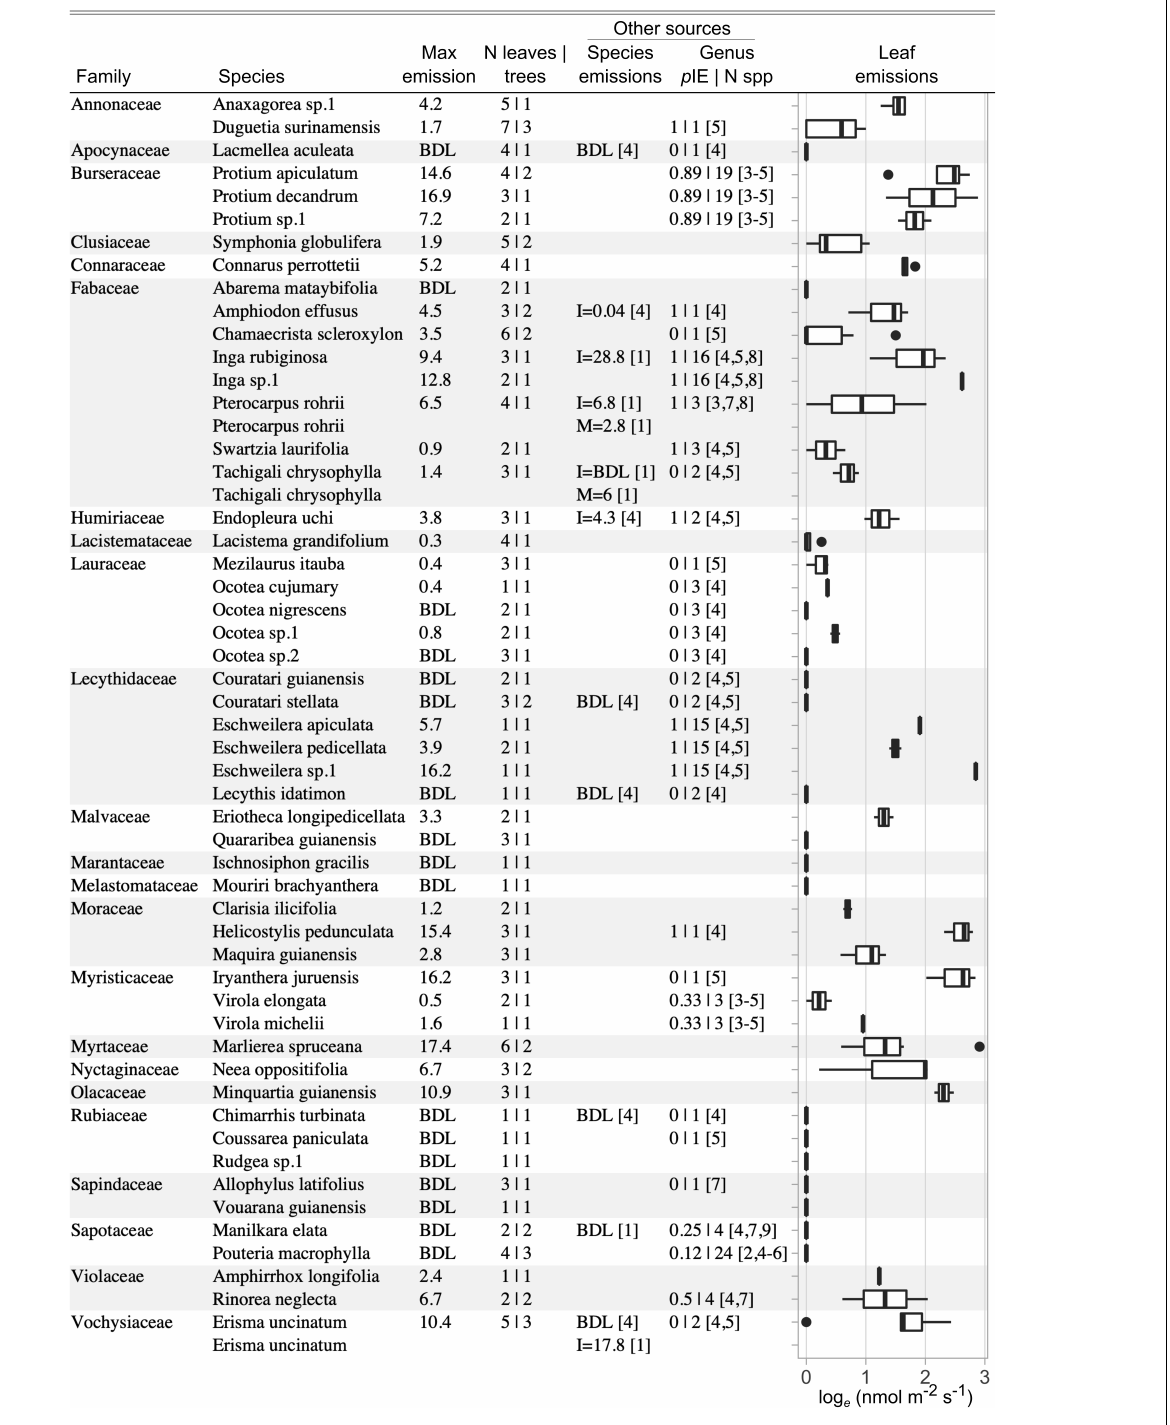
FIGURE 13 | Volatile isoprenoid emission rates from 52 tree species at an eastern Amazon site, the Tapajós National Forest, PA, Brazil. Emission rates are calculated from the end of a 210 s period of leaf illumination at 1000 PAR. Detectable emission rates were subsequently standardized to 30 ◦ C based on a standard temperature response curve. Max emission per species is provided (tabular, in nmol VI m − 2 leaf s − 1 ), as well as the distributions of emissions from all leaf measurements (graphical, log e transformed). Validation measurements by GC-MS from this study and published estimates for isoprene (I) and monoterpenes (M) from a previous study at the same site are provided for shared species. Genus level data from literature is provided in units of proportion of measured species that emit isoprene ( p IE) along with the number of species measured (N spp.). Numbered references: [1] Present study GC-MS validation measurements; [2] Bracho-Nunez et al. (2013); [3] Geron et al. (2002); [4] Harley et al. (2004); [5] Jardine et al. (2020a); [6] Klinger et al. (2002); [7] Klinger et al. (1998); [8] Taylor et al. (2018); [9] Varshney and Singh (2003).